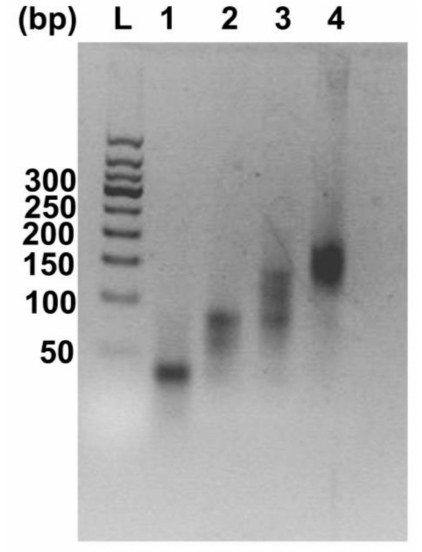
Figure 2. Agarose gel electrophoresis of the DNAs used for the formation of DNA nanostructures. Lane L is a 50 bp DNA ladder. Lanes 1–4 represent images of DNA mixtures containing 1, 2, 3, and 4 ssDNA chains,